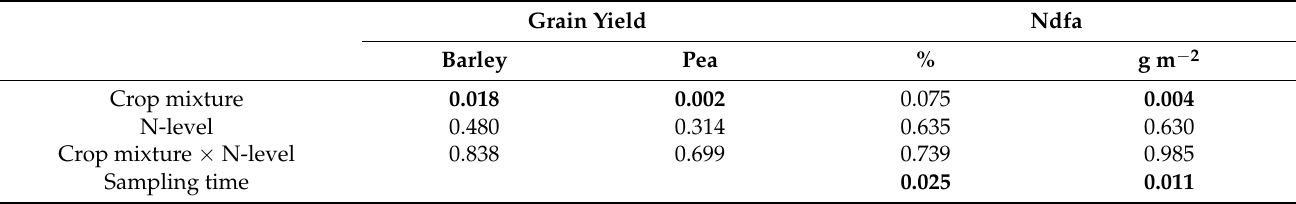
Table A6. p -values following analysis of variance of crop grain yields (kg DM ha − 1 ) and relative (%) and absolute amount (g m − 2 ) of N derived from air (Ndfa) in pea in dependency of the crop mixture (as sole-crop or intercrop), N-level, sampling time (flowering and maturity) and their interactions. p -values smaller 0.05 are marked in